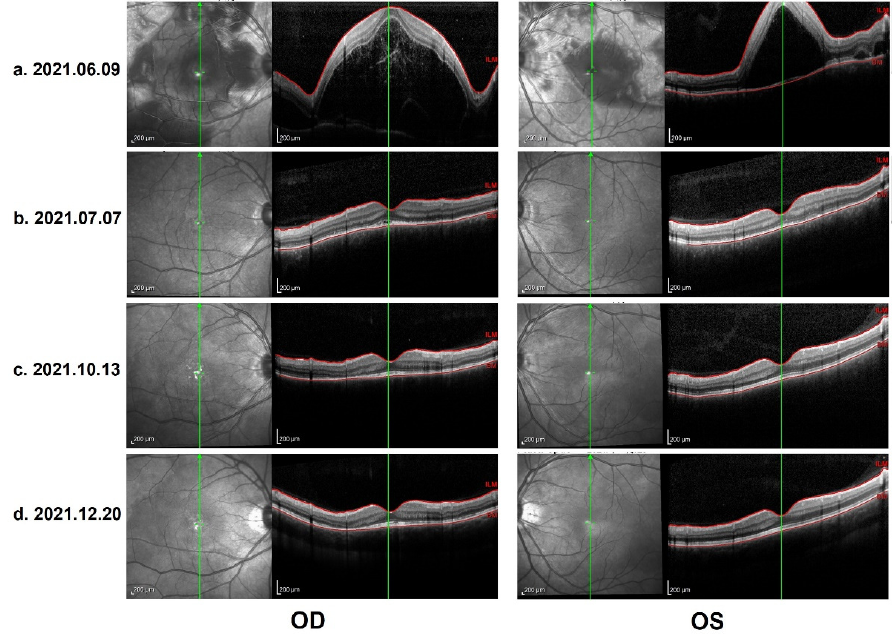
Figure 3. ( a ) OCT on 9 June 2021: Heidelberg optical coherence tomography (OCT): bullous serous retinal detachment, retinal pigment epithelium (RPE) undulation and membranous structure on the RPE beneath the foveal cystoid space. ( b ) Control OCT on 7 July 2021: total resolution of subretinal fluid, discontinuous inner segment/outer segment (IS/OS) layer and rough RPE. ( c ) Control OCT on 13 October 2021: further improvement in IS/OS layer and RPE, with a melanin change in the choroid stroma. ( d ) Control OCT on 20 December 2021 (the last evaluation): stable and similar to the previ ‐ ous follow ‐ up.